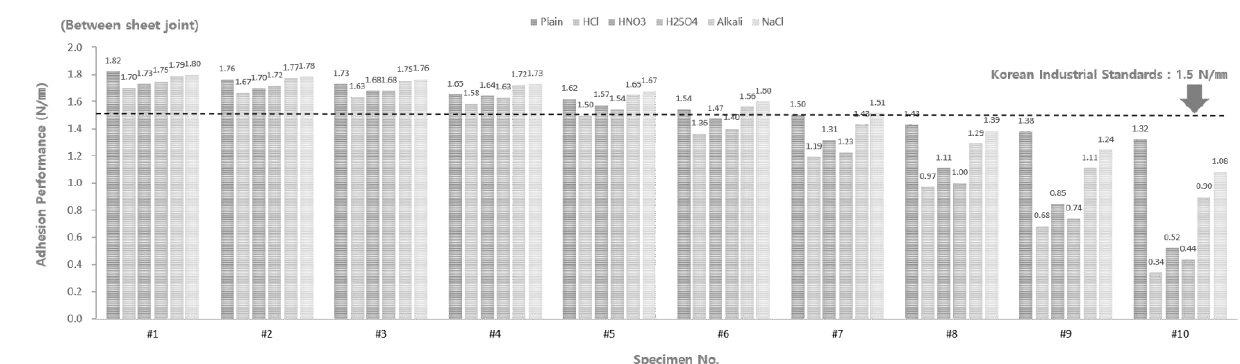
Figure 14. Adhesion performance test result (between sheet joint).